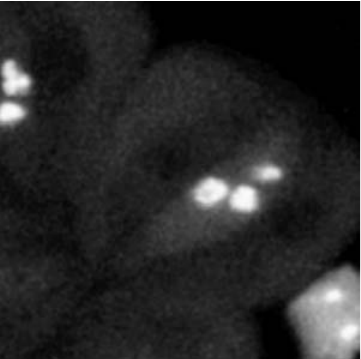
correlate with the orientation of the anastral spindle.